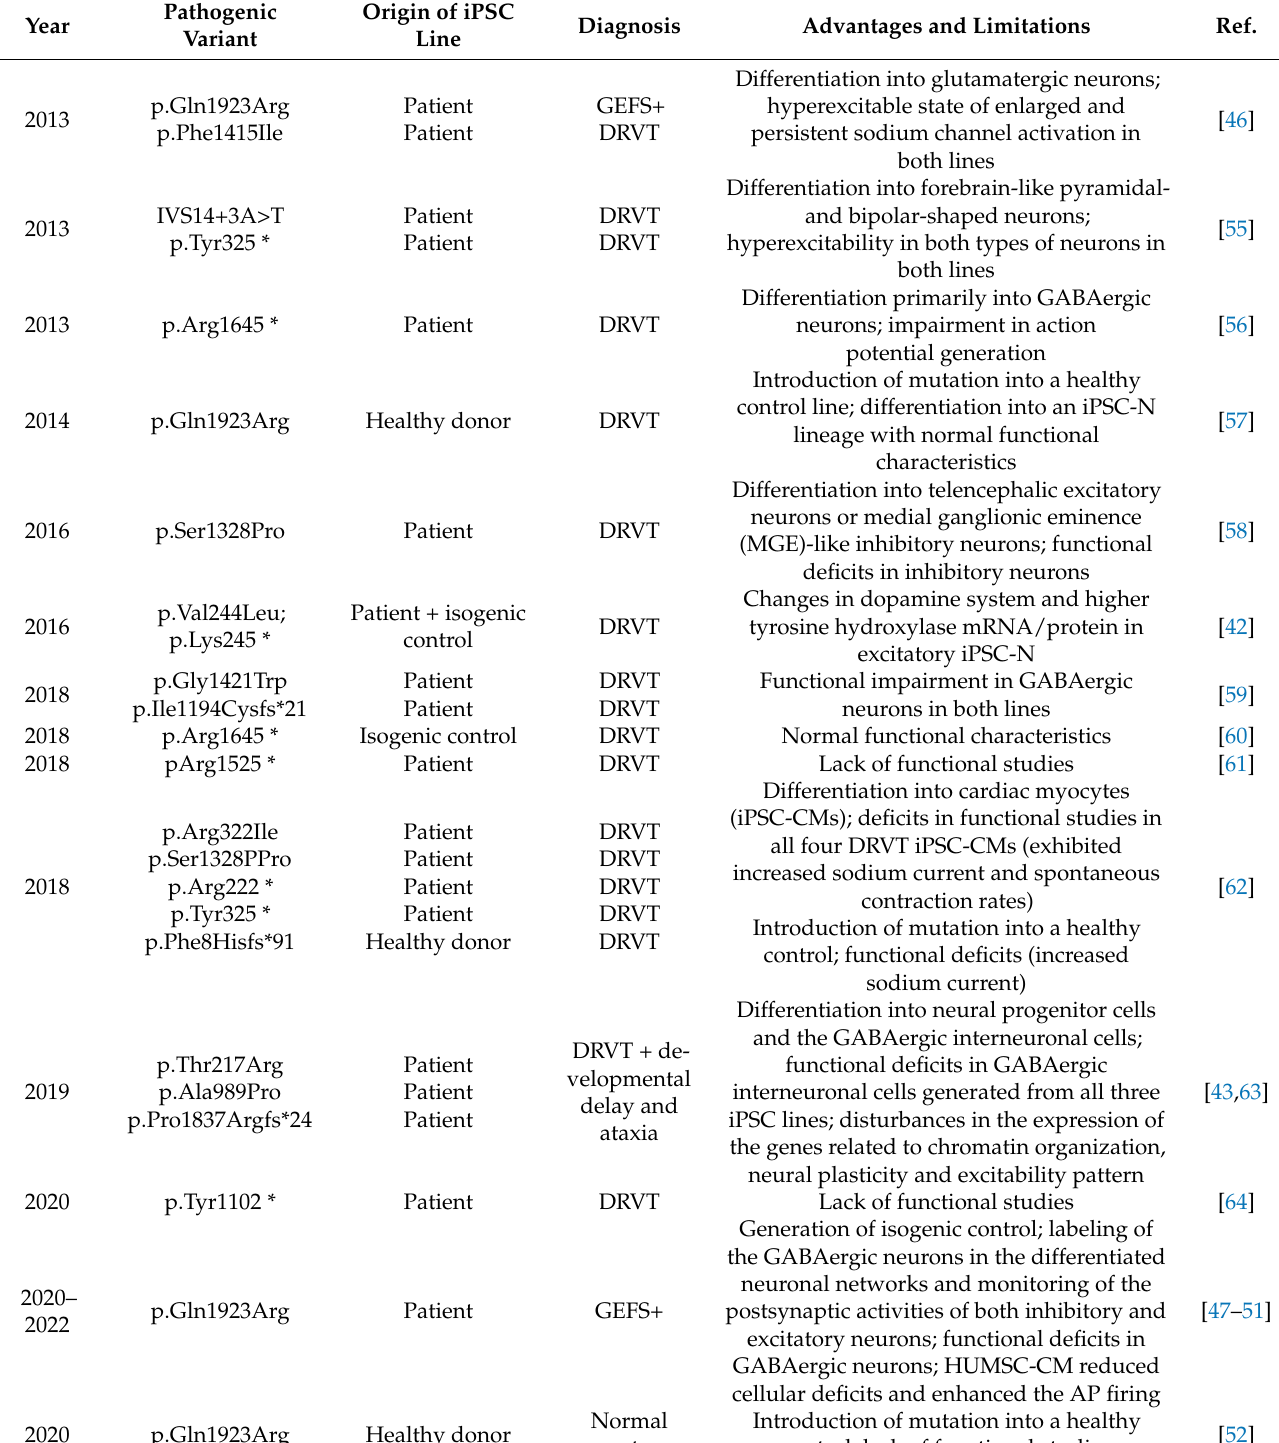
Table 1. The timeline represents the historic order of the iPSC-based models in the study of SCN1A /Nav1.1 pathogenic